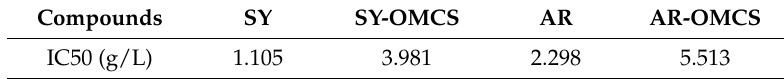
Table 3. IC50 values of edible colorants on human liver cell lines